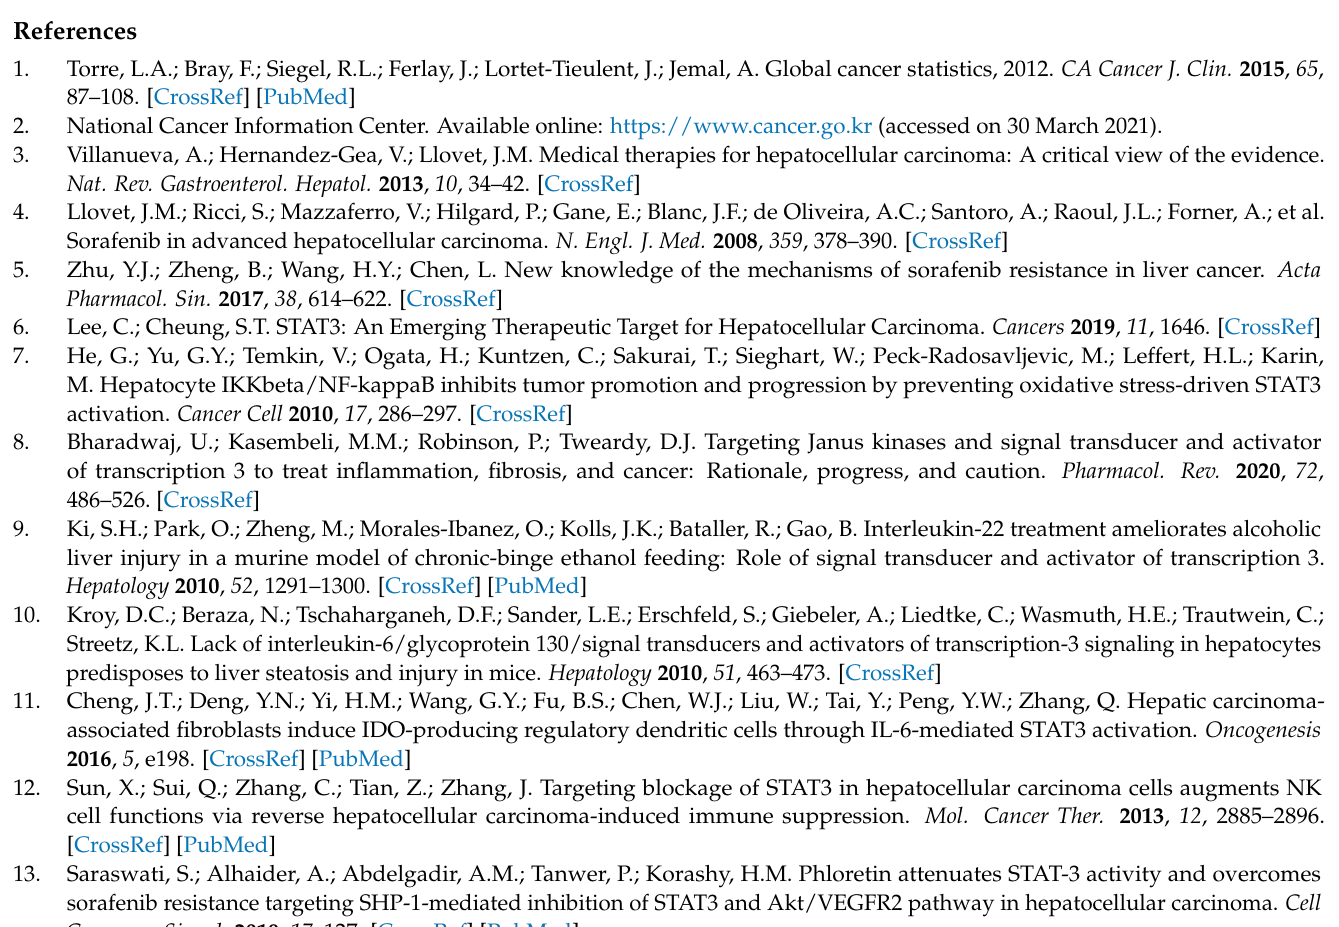
Figure S2: qPCR analysis, Figure S3: Nrf2 transactivation by HsA, Figure S4: effect of compound C on HsA-mediated toxicity, Figure S5: Effect of HsA on Akt and NF- κ B phosphorylation in HCC